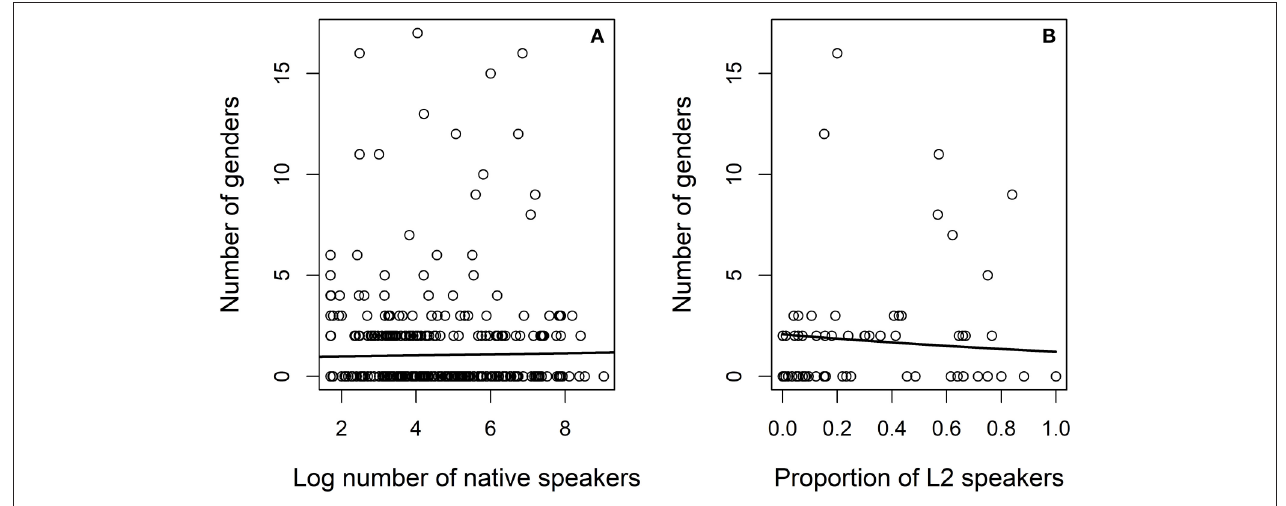
FIGURE 12 | Number of genders as a function of log number of speakers on the left (A) and for the proportion of L2 speakers on the right (B) .